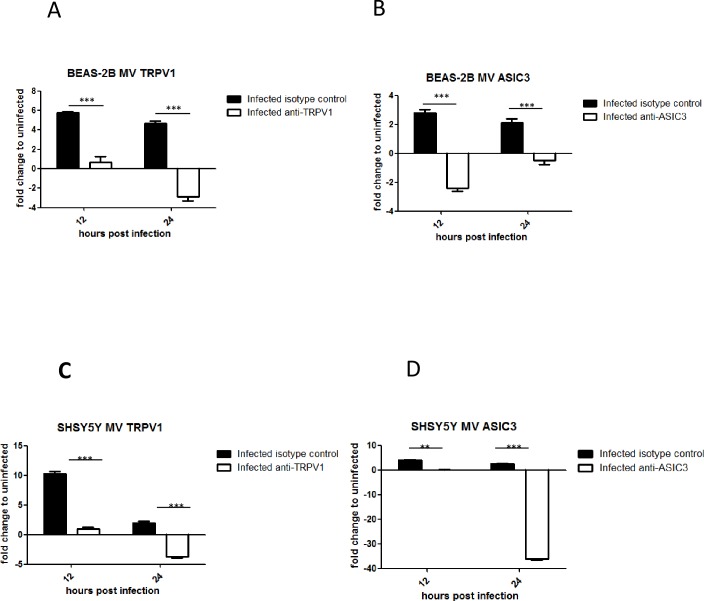
Antibodies to TRPV1 and ASIC3 inhibit up-regulation of these receptors by virus infection.BEAS-2B and SHY5Y5 cells were treated for 1 hour with either anti-TRPV1 or anti-ASIC3 antibodies or with non-immune rabbit serum before infection with MV (MOI 1) or mock infection. Antibodies were left in the culture throughout the experiment. TRPV1 and ASICS3 mRNA levels were determined by qRT-RT. (A) and (B) BEAS-2B cells; (C) and (D) SHSY5Y. (A) and (C) TRPV1, (B) and (D) ASIC3. Fold change was determined relative to uninfected, untreated cells.